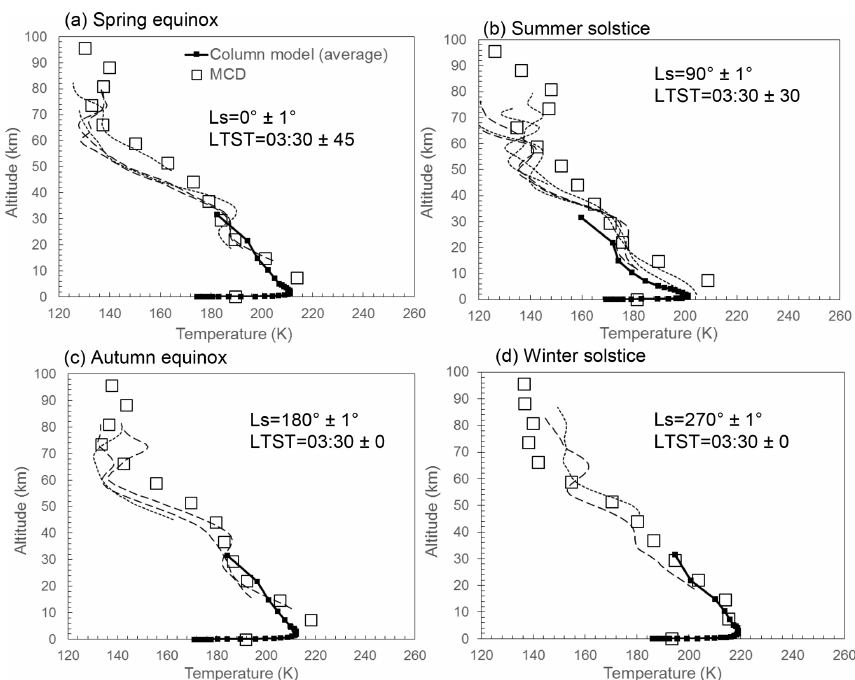
Figure 5. MSL site night-time atmospheric temperatures observed by the Mars climate sounder together with temperatures from the column model. Overlaid, as a check, are data from the MCD. As for Figs. 3–4 but for the MSL site (4.6 ◦ S, 137.4 ◦ E). Mars year 29 (Earth year 2008) for L S = 90 ◦ and Mars year 33 (2015–2016) used for all areocentric longitudes.